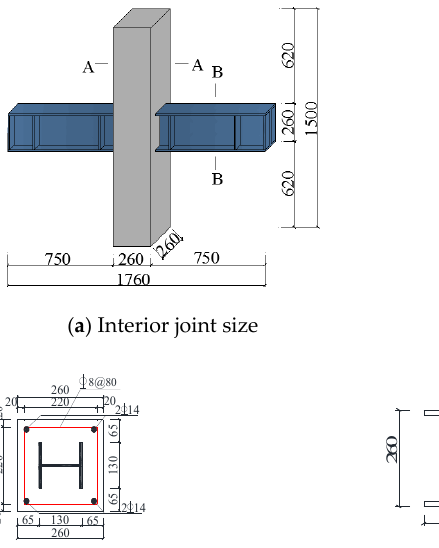
each joint are shown in Table 3.